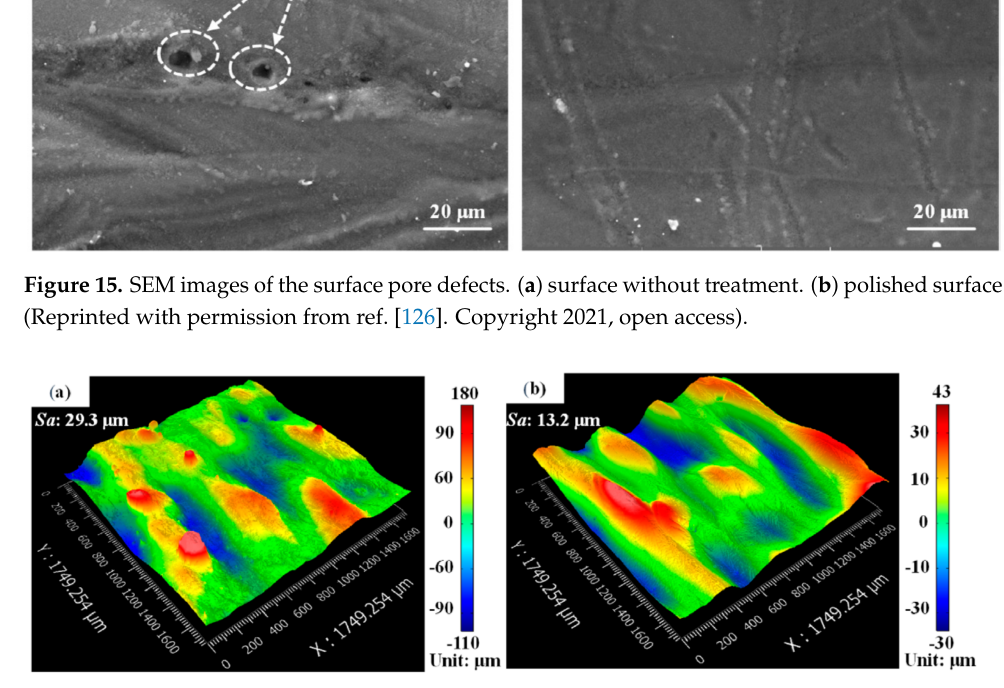
Figure 16. Optical morphologies of the surface. ( a ) surface without treatment. ( b ) polished surface. (Reprinted with permission from ref. [126]. Copyright 2021, open